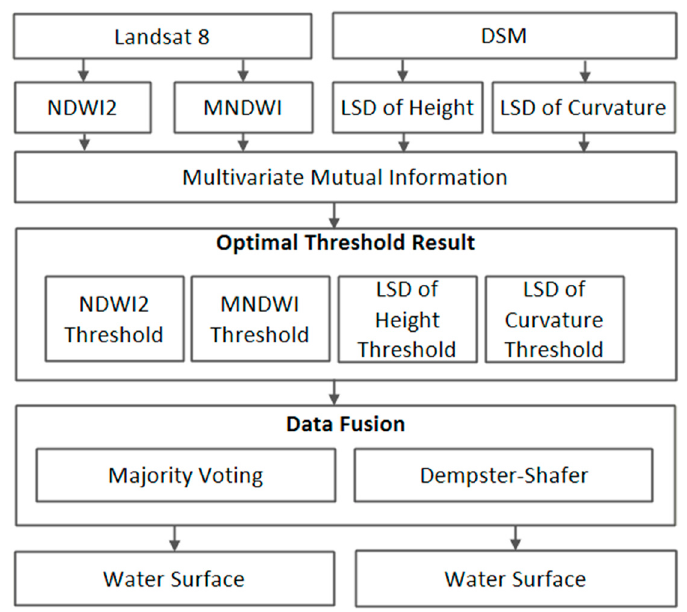
Figure 1. The proposed automated water surface extraction methodology.